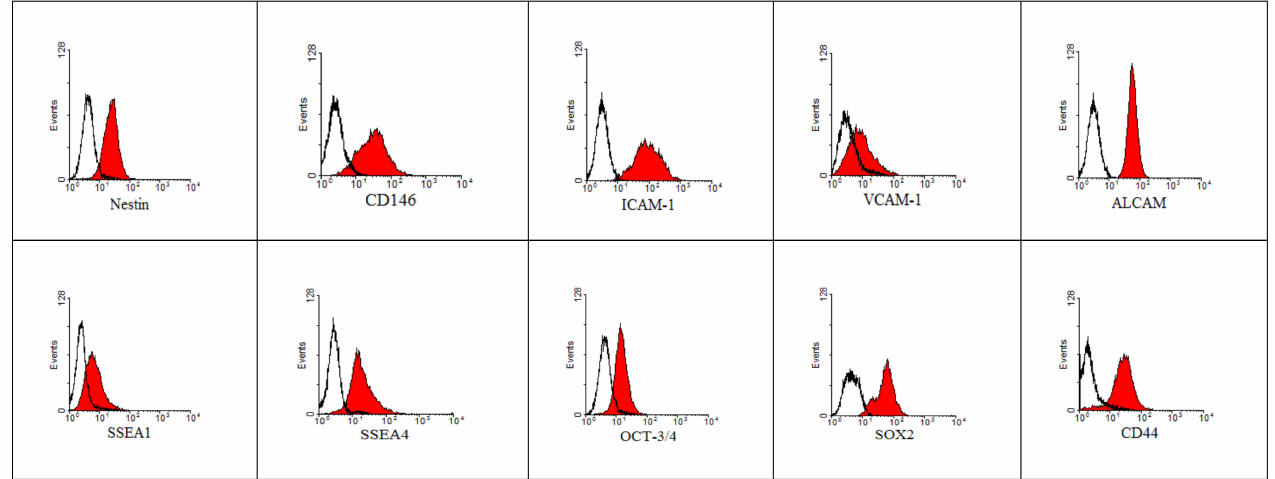
Figure 3. Antigen characteristics of established human HATMSC1 cell line derived from adipose tissue. The mean fluorescent intensity of cells was reported on the x-axis and the number of cells (events) on the y-axis. Black line curves represent isotypic control; red fields represent cells positive for presented